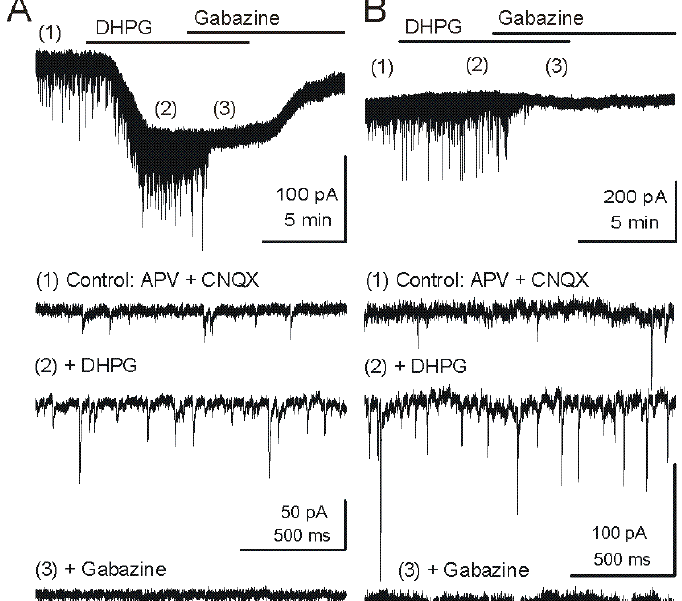
Figure 2. Metabotropic glutamate receptor (mGluR) group I agonist DHPG increases